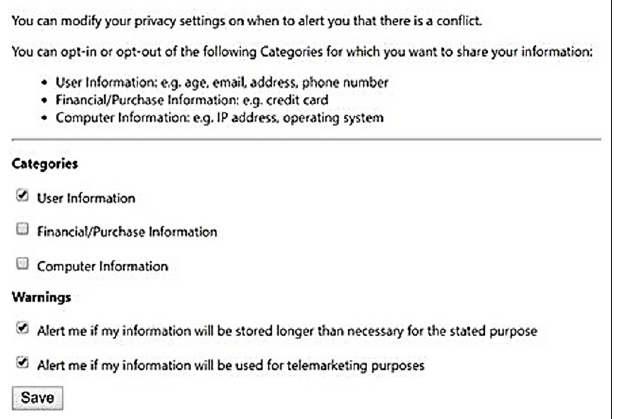
FIGURE 2 | User privacy preference editing tool. FIGURE 3 | Original form